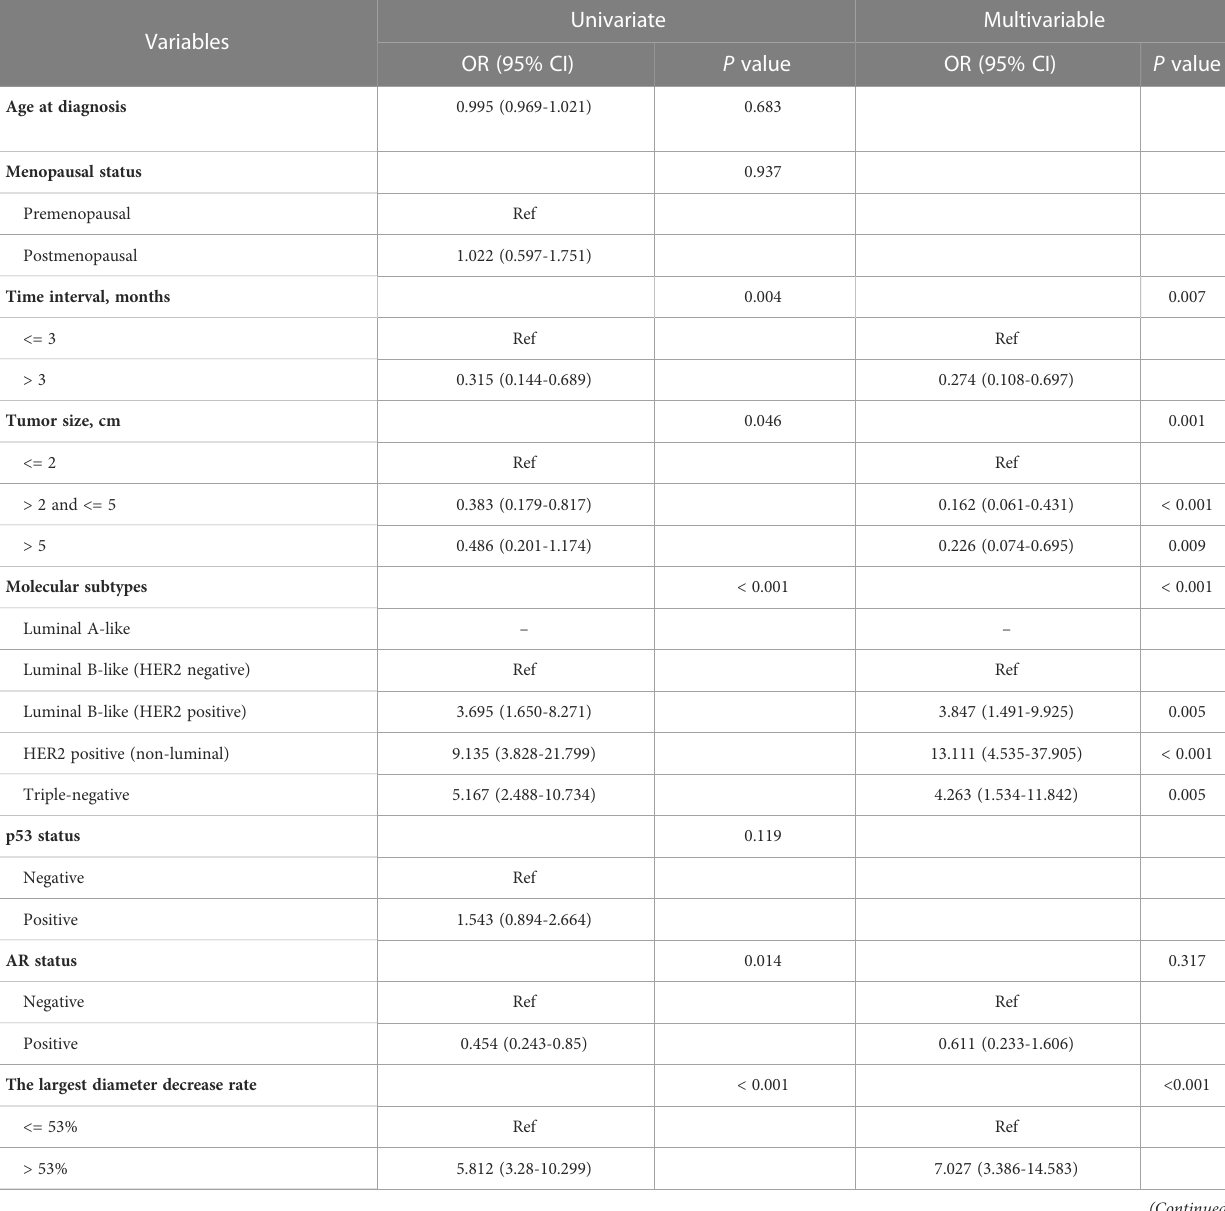
TABLE 2 Univariate and multivariable logistic regression model for predicting pathological complete response in the training